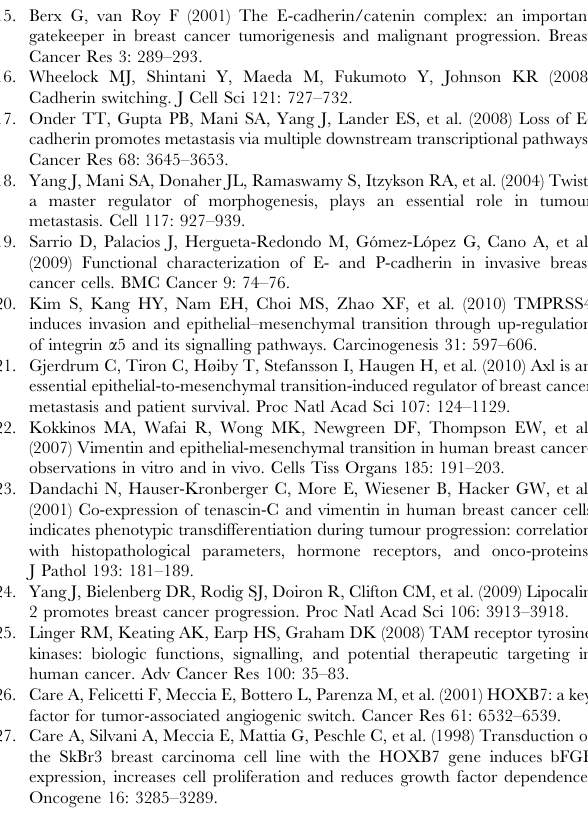
overexpression in pII cells and green nodes underexpressed transcripts, with un-coloured nodes as unaltered expression. (TIF) Figure S2 A molecular interaction node depicted by Ingenuity Pathway Analysis centered on molecules involved in cellular motility and subdivided into cellular component/location. The nodal relationships are shown by solid lines indicating direct known interactions and dashed lines for indirect interactions. Additionally, the shape of each node indicates the molecular class. Red nodes indicate overexpression in pII cells and green nodes underexpressed transcripts, with uncoloured nodes as unaltered expression. (TIF) Figure S3 Realtime RT-PCR analysis of epithelial [ER, CDH1, K19] and mesenchymal (PLAU, VIM, CDH12, CD68, FN1 and VEGF) markers in MCF7, pII and MDA231 cells. Extracted RNA was converted to cDNA and amplified using Taqman procedures as described in Methods. Expression was normalized to the DD Ct value for MCF-7 cells, with b actin used as an internal control. Data is expressed as a fold change from MCF7 which was arbitrarily fixed at 100. Histobars represent means of duplicate determinations. Similar results were observed in two separate experiments.